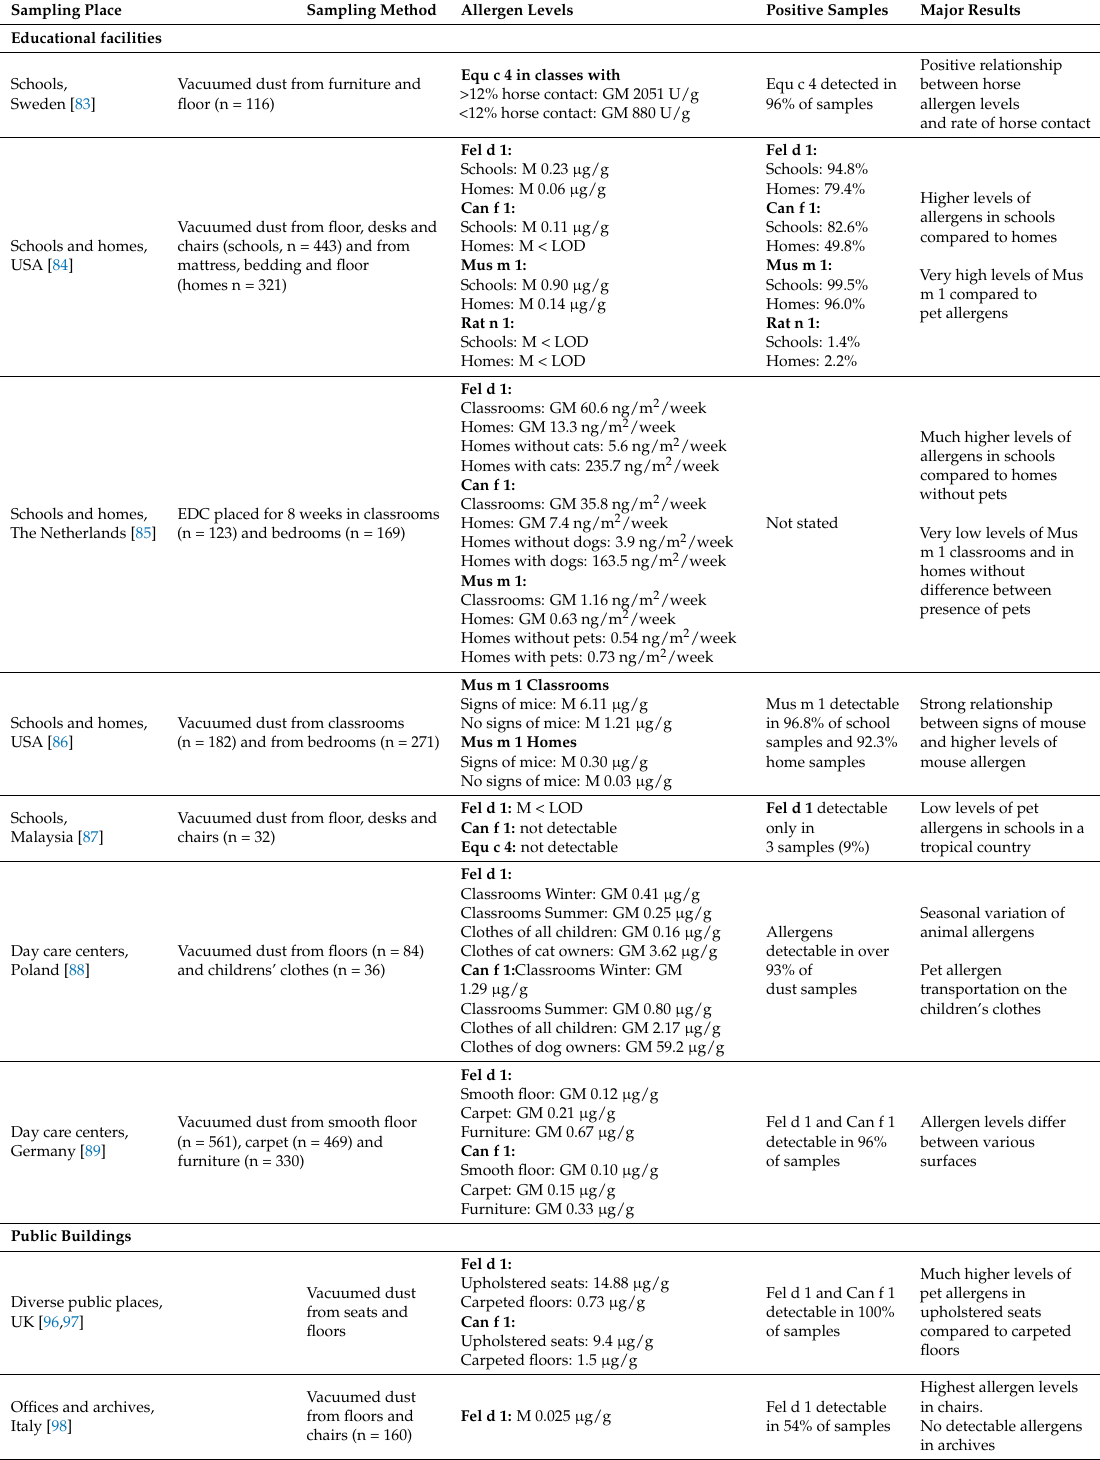
Table 2. Animal allergen levels in public or work places without the presence of